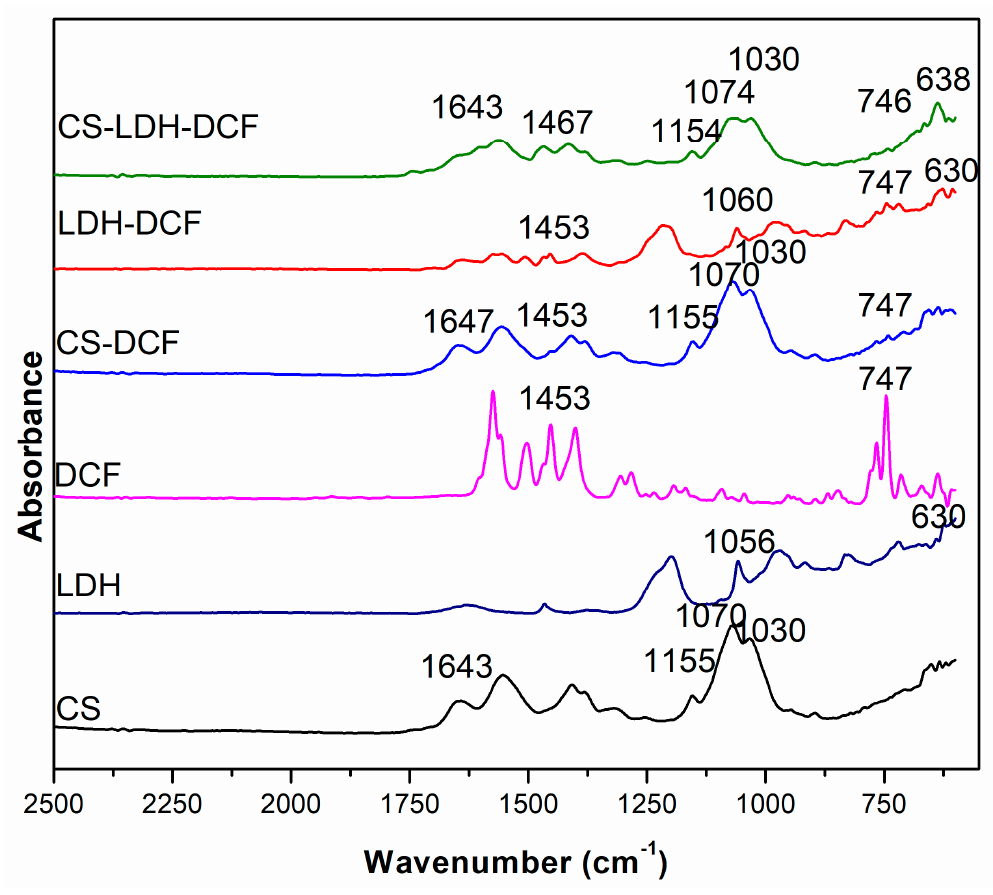
Figure 5. FTIR spectra for CS, LDH, DCF, CS-DCF, LDH-DCF, and CS-LDH-DCF.